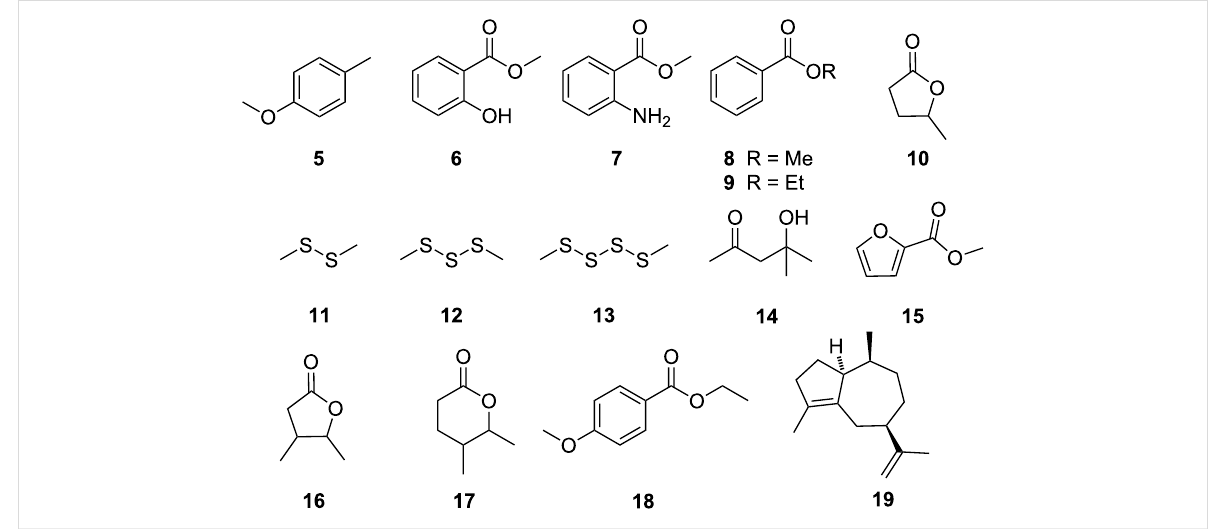
Figure 3: Volatiles released by mycobacteria and Nocardia spp. grown on a 7H11 solid medium.